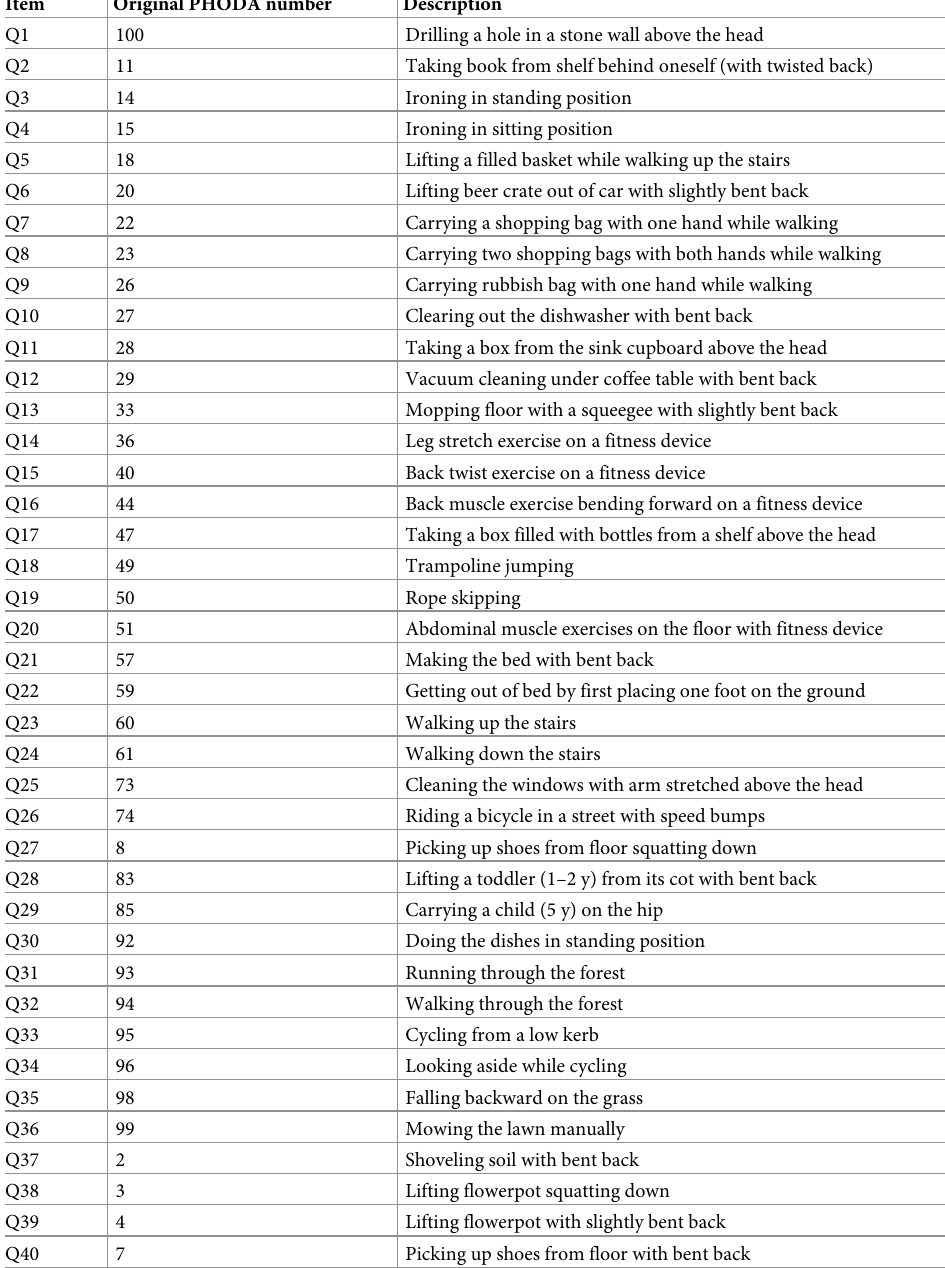
Table 1. Description of items of the PHODA-SeV